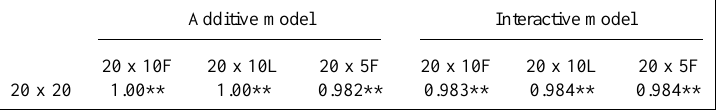
Table X - Correlations between general reaction ability (GRA) estimates from different numbers of races infecting the 20 hosts, according to additive and interactive models. Additive